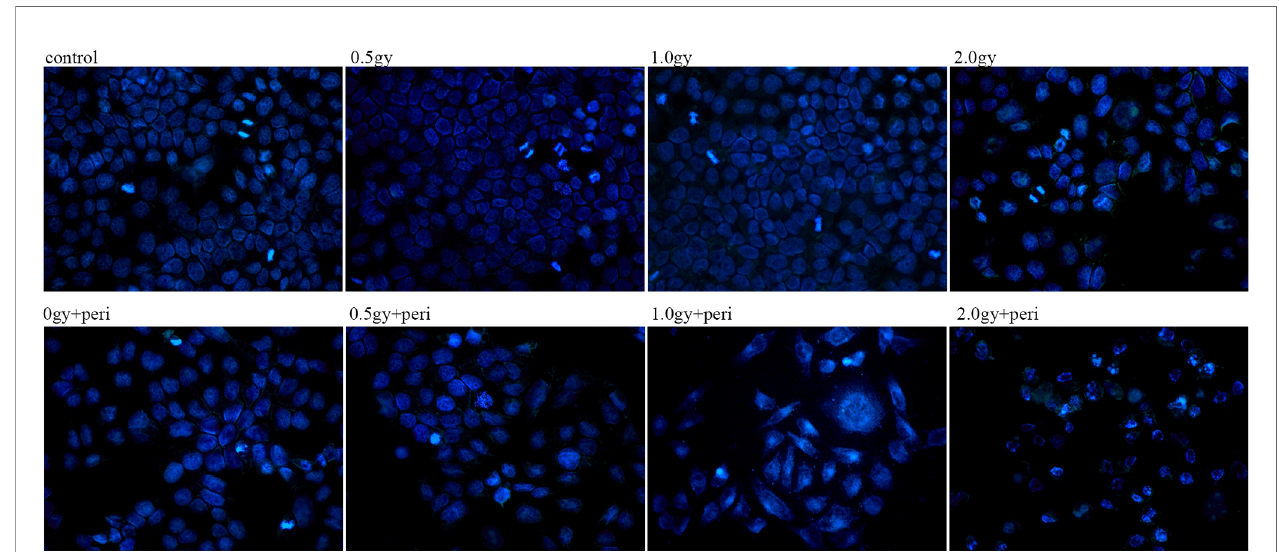
FIGURE 5 | After heavy-ion irradiation with or without perifosine, cells were stained with Hoechst 33258, and abundant apoptotic bodies were observed in perifosine treated groups.